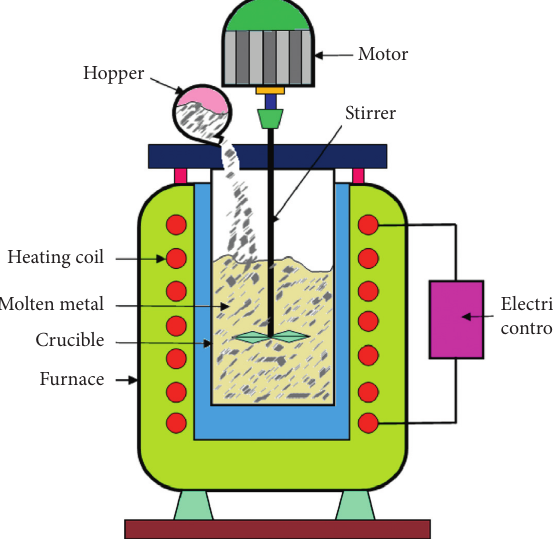
Figure 1: Schematic view of stir casting process.